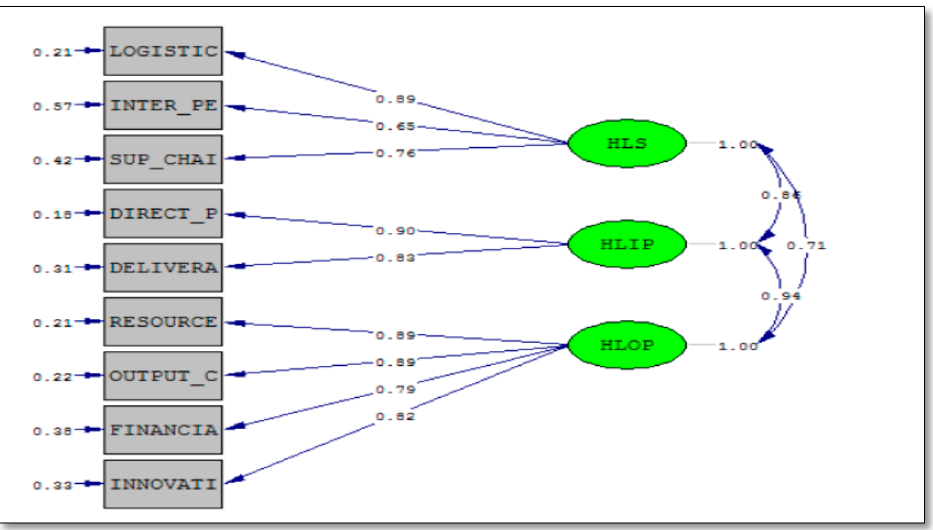
Figure 10. Measurement model (Source: LISREL output).